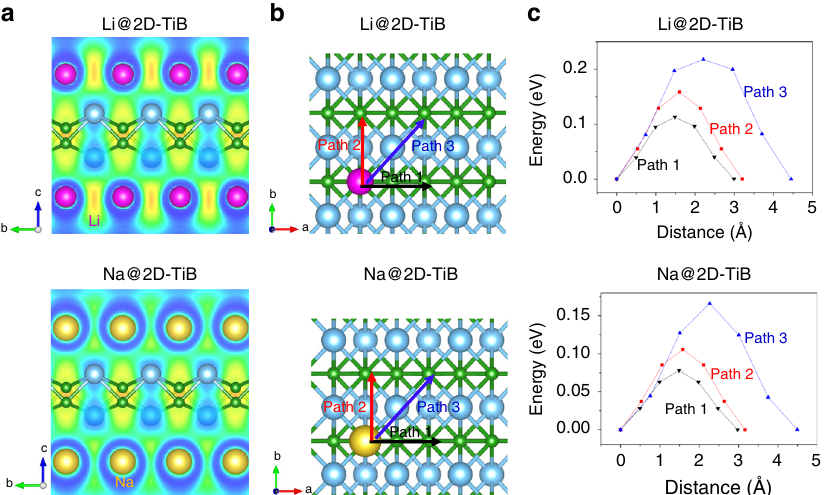
Fig. 5 Adsorption and diffusion behavior of Li and Na on 2D TiB ( Cmcm ). a ELF maps of a pristine TiB monolayer with one layer of Li atoms and one layer of Na atoms. b Considered diffusion paths for Li and Na on the TiB monolayer. c Calculated diffusion energy barriers along the paths in b . The purple and yellow spheres represent Li and Na atoms,